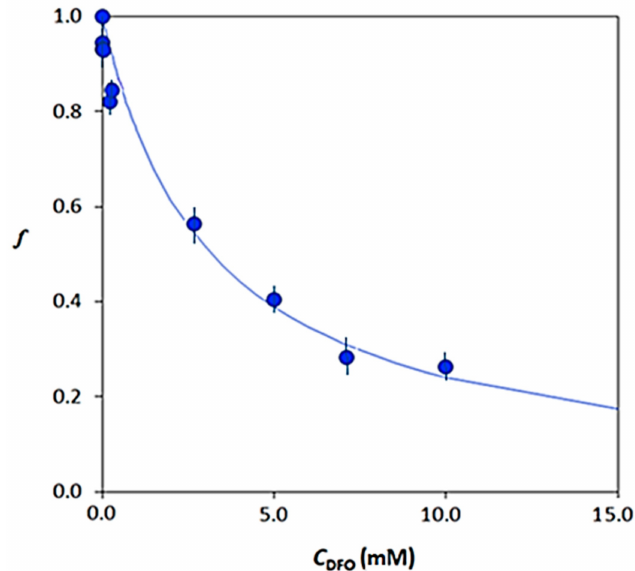
Figure 7. Desorption profile of Fe(III) from Fe(III)-3,4-HP@EVOH, at pH 7, as a function of the DFO concentration added in solution. Discontinuous procedure. Solid phase: Fe(III) enriched 3,4-HP@EVOH (circular clips 3.5 mg); solution phase: PIPES bu ff er 0.1 M at pH 7, V = 1.5 mL. Error bars represent the standard deviation on three